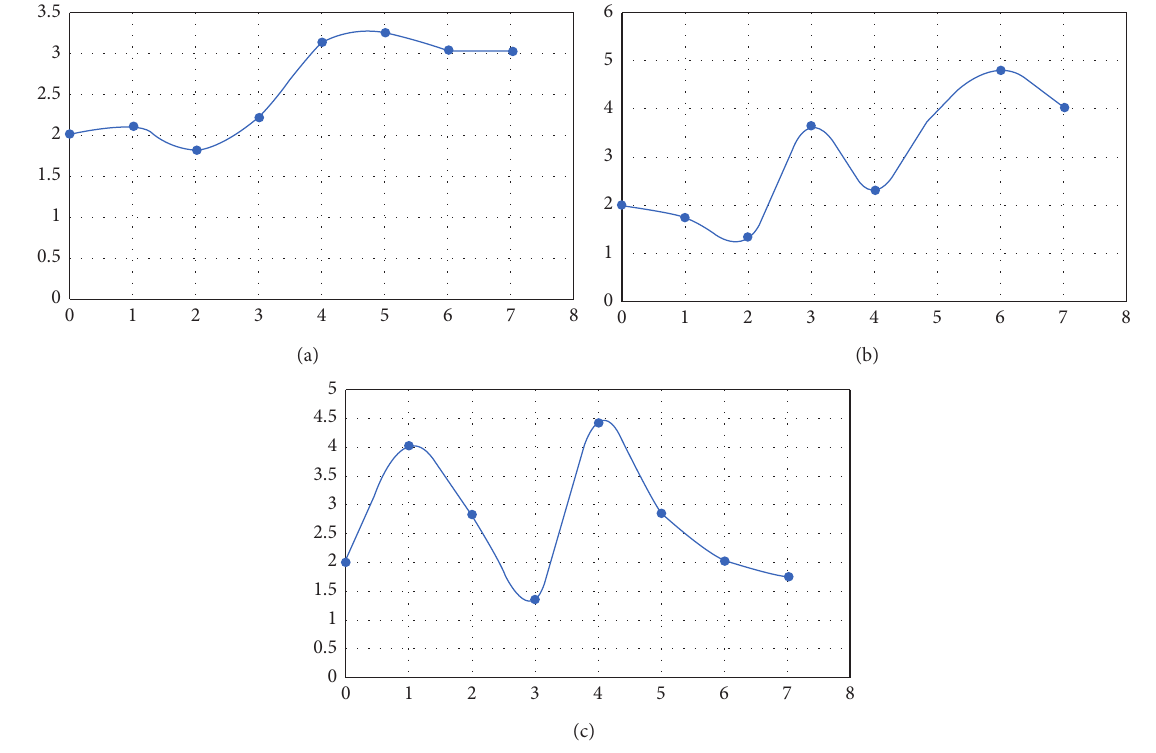
Figure 6: Test results of three different methods. (a) Test results of method 1. (b) Test results of method 2. (c) Test results of method 3.